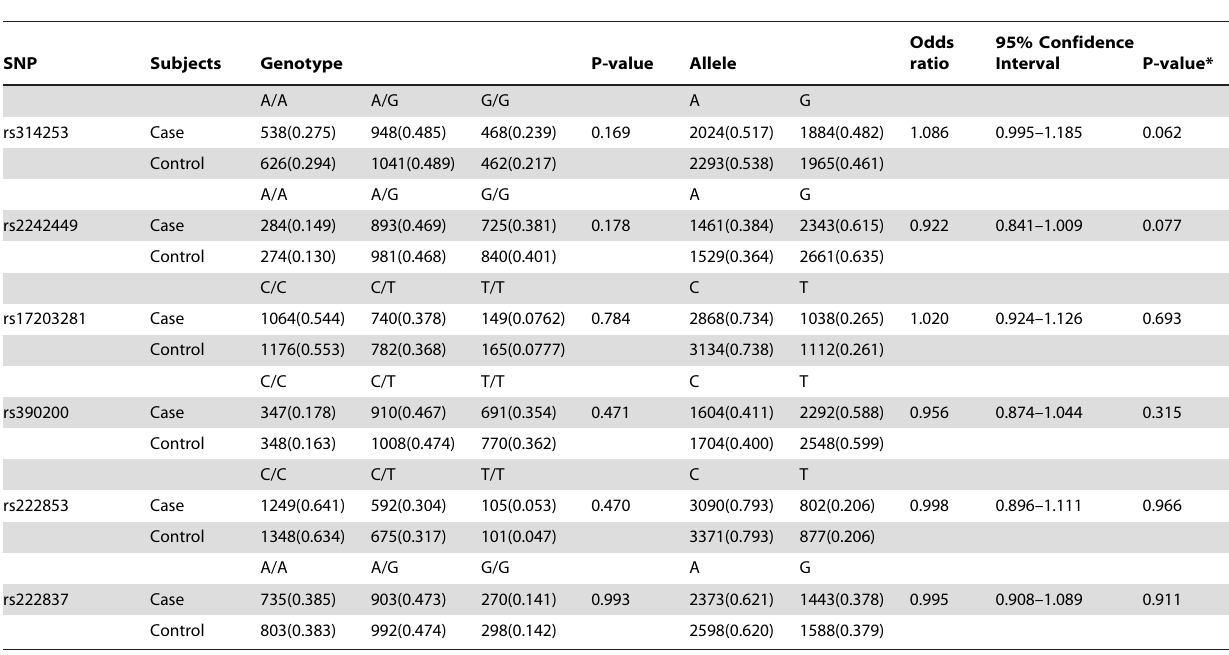
Table 3. Case control association analysis of the DLG4 in Japanese schizophrenia patients.